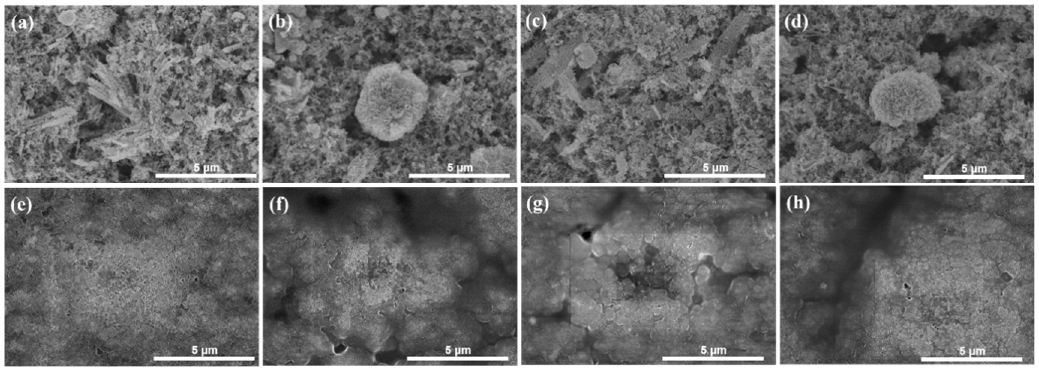
Figure 11. SEM images of the ( a–d ) fresh electrode and ( e–h ) cycled electrode (500th cycle at 500 mA·g − 1 ) using ( a,e ) Co 3 O 4 -Cl, ( b,f ) Co 3 O 4 -SO 4 , ( c,g ) Co 3 O 4 -AC, and ( d,h ) Co 3 O 4 -NO 3 as active materials.